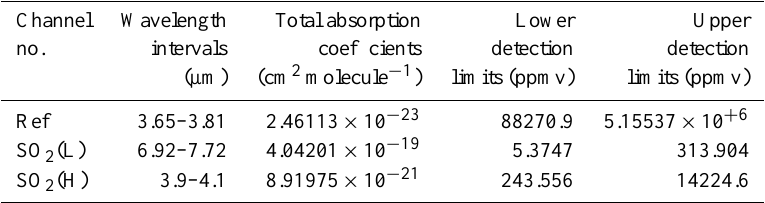
Table 2. Total absorption coefficients, lower and upper detection limits of Ref, SO 2 (L) and SO 2 (H) calculated using the parameters in Table 1.